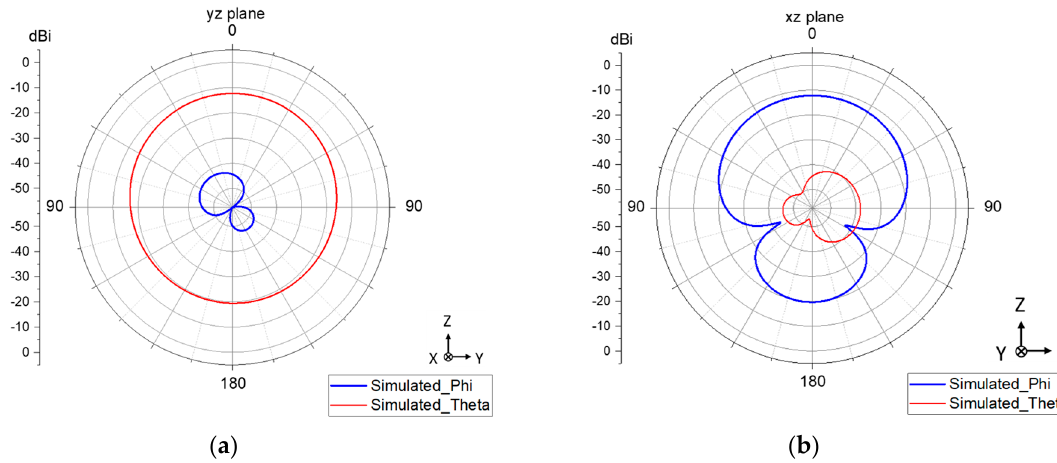
Figure 22. 2D field simulation at 38 GHz: ( a ) yz plane; ( b ) xz plane.